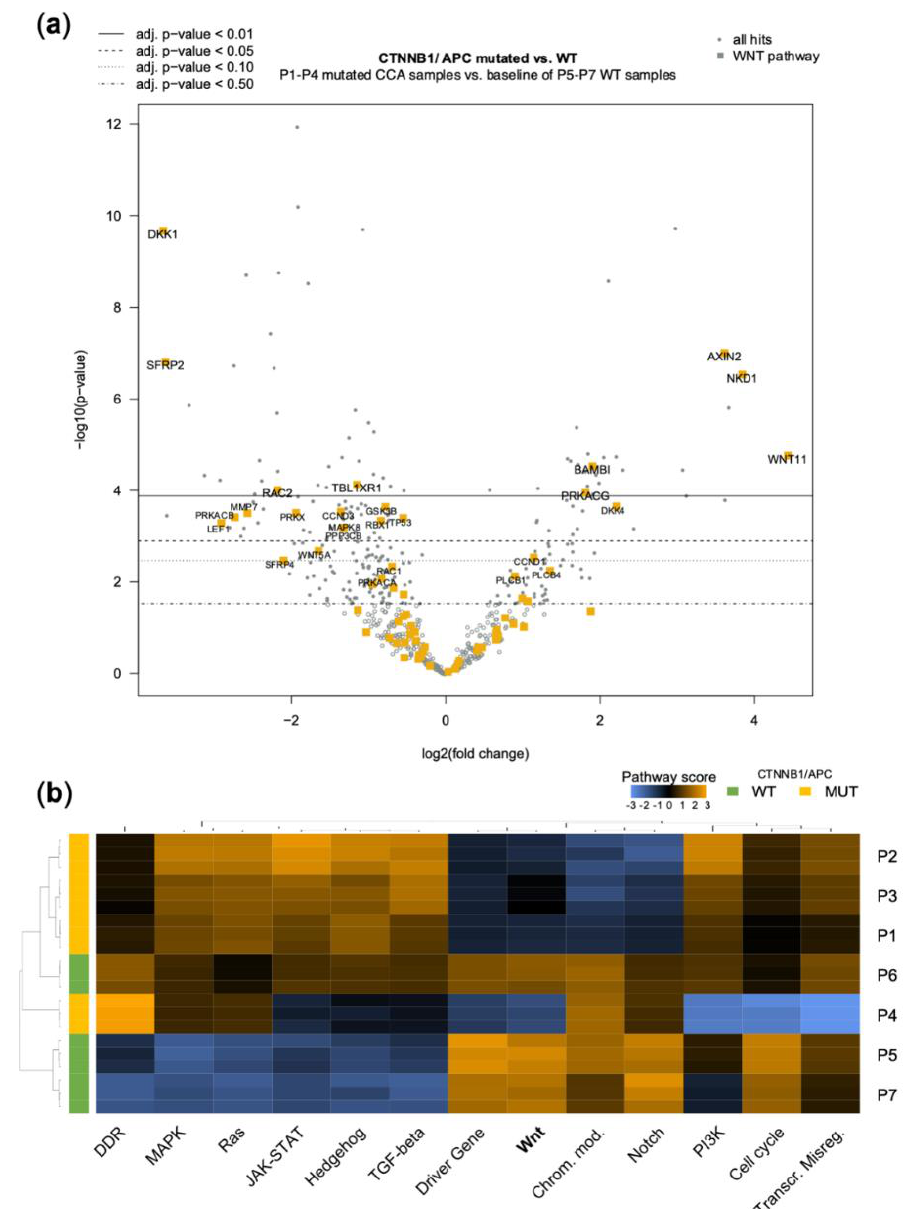
Figure 7. ( a ) Volcano plot of Nanostring ® mRNA measurement using the human Pan Cancer pathway panel ® with highlighted Kegg WNT-pathway hits. Comparison of the CTNNB1 mutated CCA (P4) and the APC mutated CCA samples (P1–P3) with the three WNT pathway wild-type CCA samples (P5–P7). ( b ) Heatmap showing pathway scores across indicated patients to illustrate clustering of pathways within samples. Orange indicates high pathway scores; blue indicates low scores (with undetermined/arbitrary functional dimension). P, patient